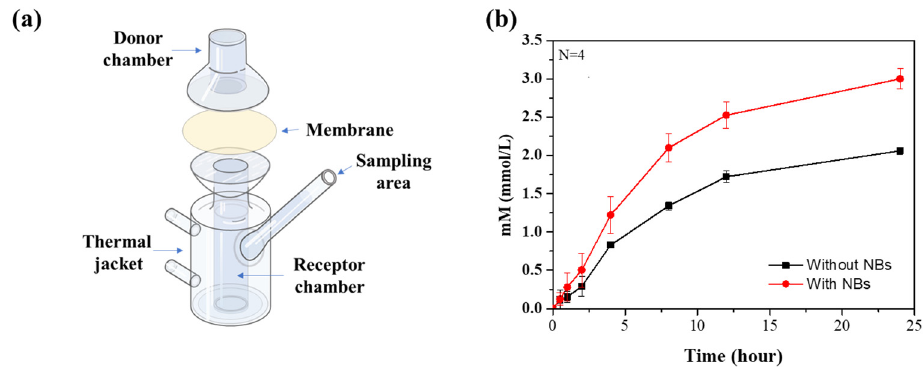
Figure 2. ( a ) Illustration of Franz cell. ( b ) Cumulative concentration of ingredients across the membrane at room temperature.